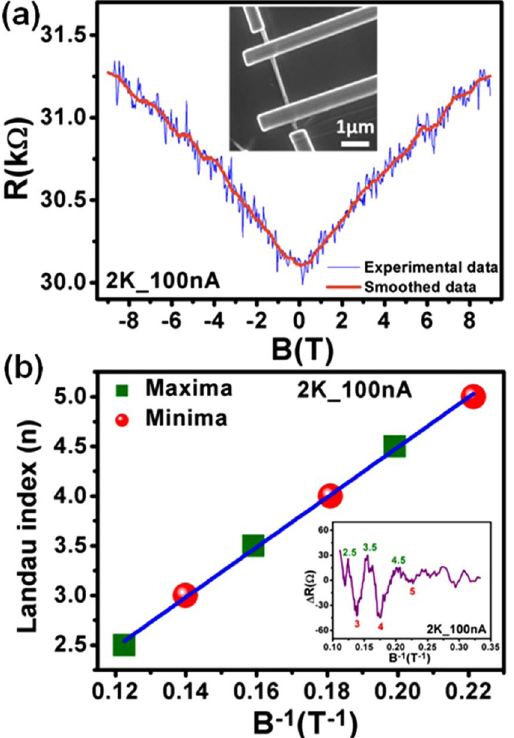
Figure 1. Landau level fan diagram analysis. ( a ) M-R for device W3 shows a positive fluctuating behaviour at 2 K (in blue). The smoothed M-R (shown in red colour) depicts oscillatory behaviour in the background at high magnetic fields. Inset shows the FESEM image of the nanowire device. ( b ) Landau fan diagram for the smoothed M-R curve, with maxima and minima positions as shown in the